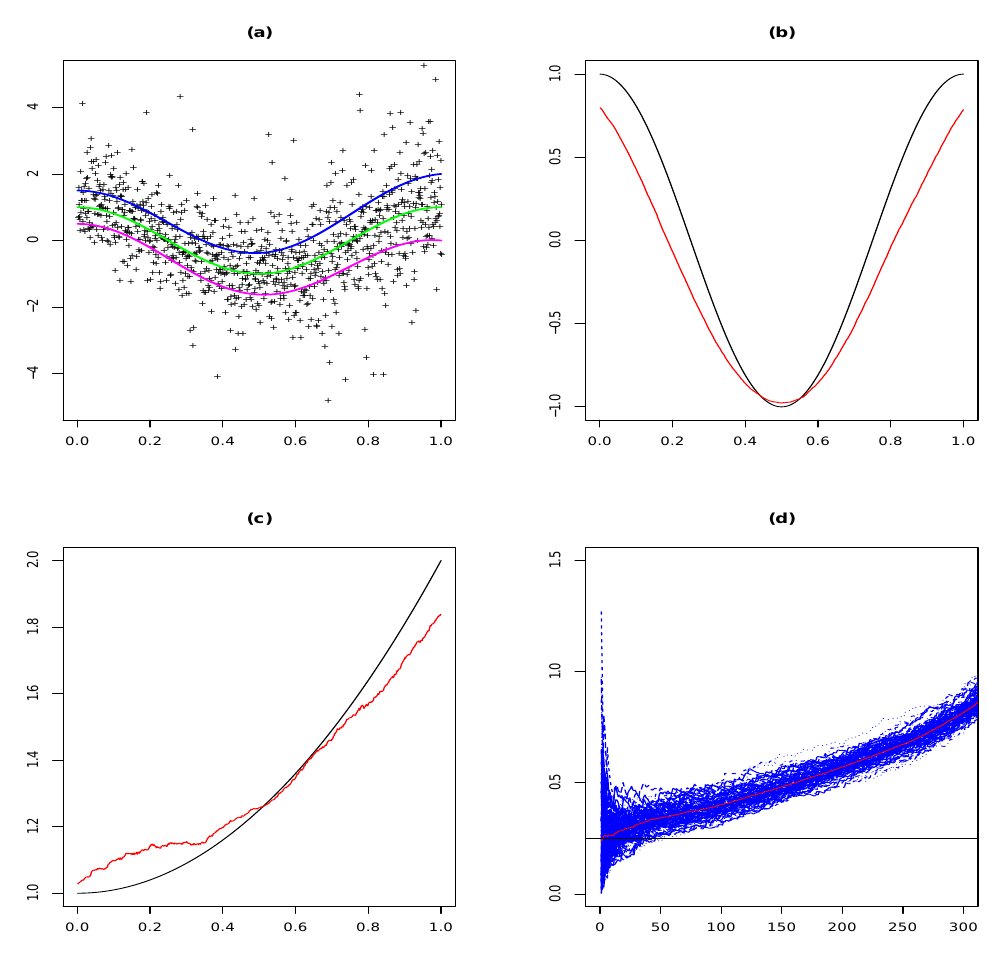
(·) (red). (c): Scale function b (·) (black) and n